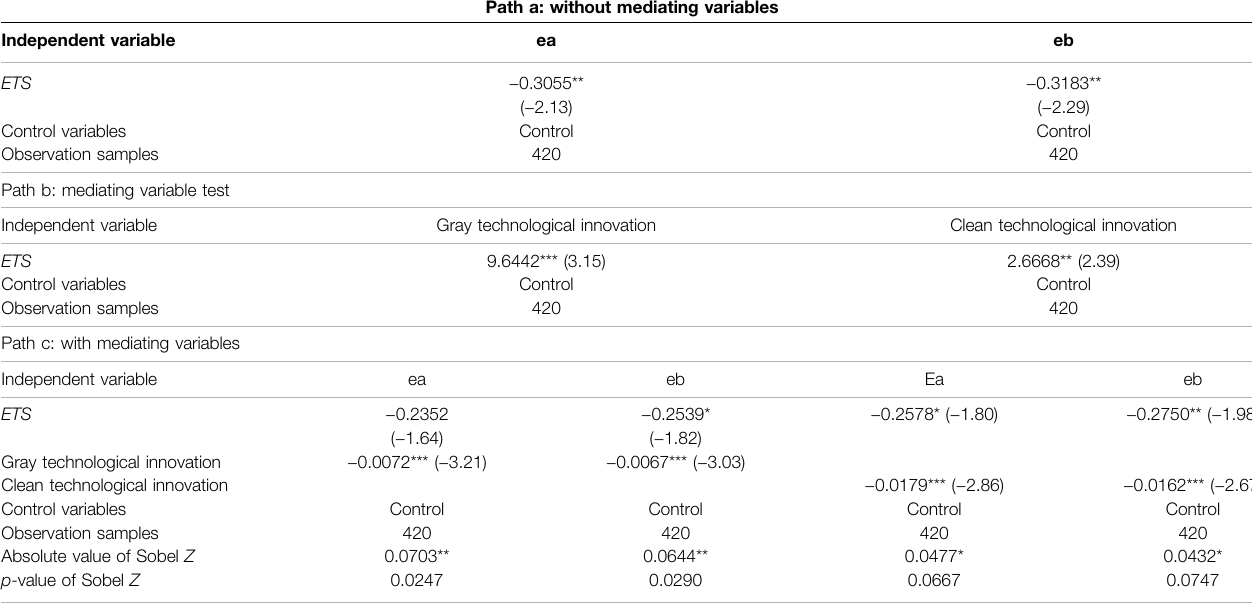
TABLE 6 | Mediating effects and Sobel test results.